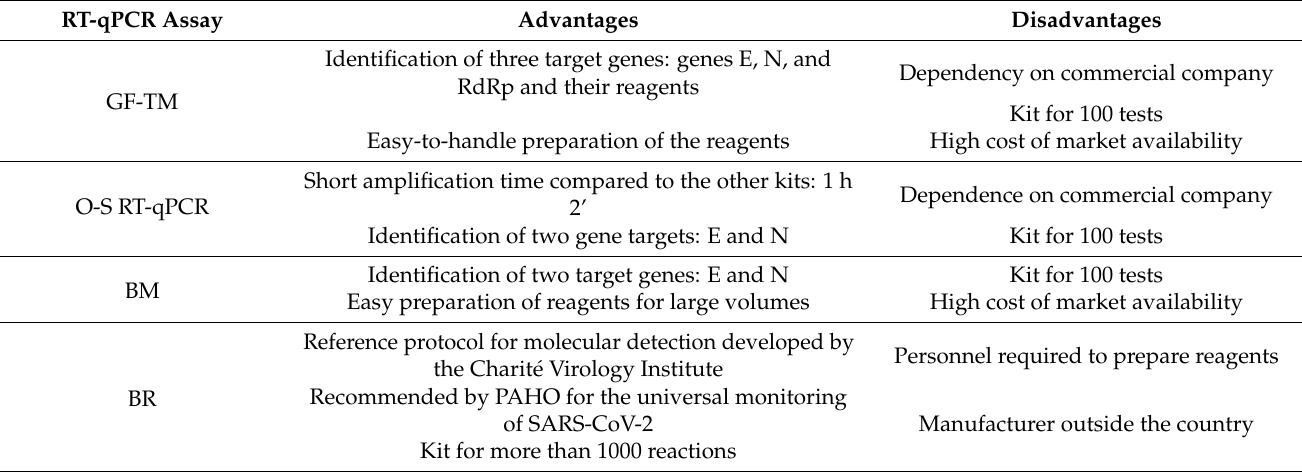
Table 5. Summary of the basic advantages and disadvantages of the real-time polymerase chain reaction assays used to screen for severe acute respiratory syndrome coronavirus 2